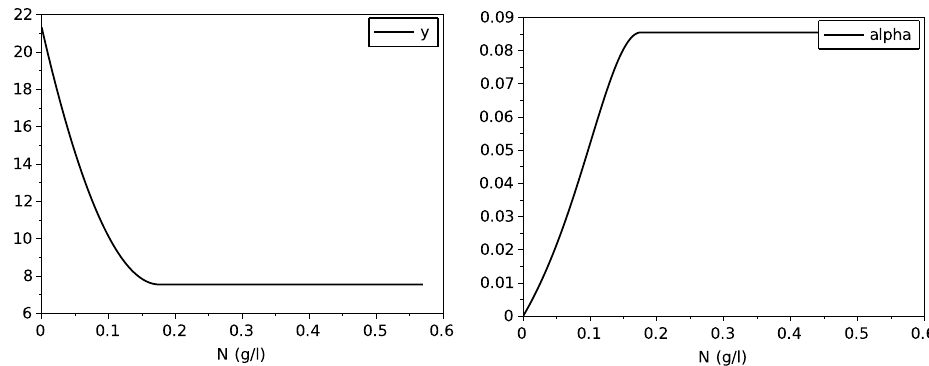
Figure 3. Graphs of the obtained variable yield function y and of the function α .